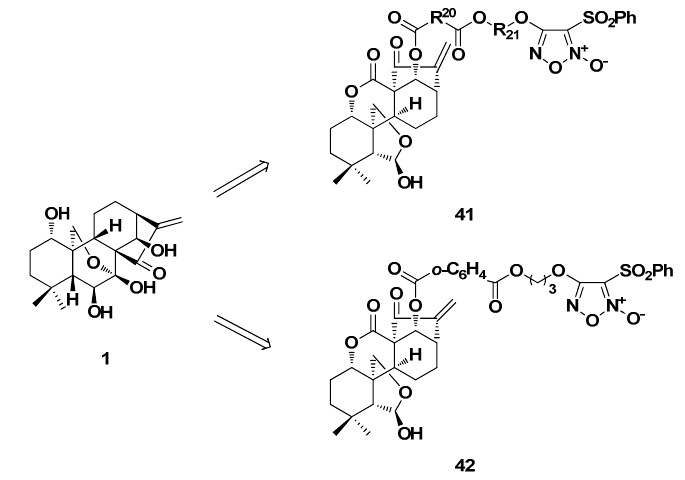
Figure 20. Antimycobacterial enmein-type 6,7- seco -kaurane diterpenoid derivatives 37 – 40 .